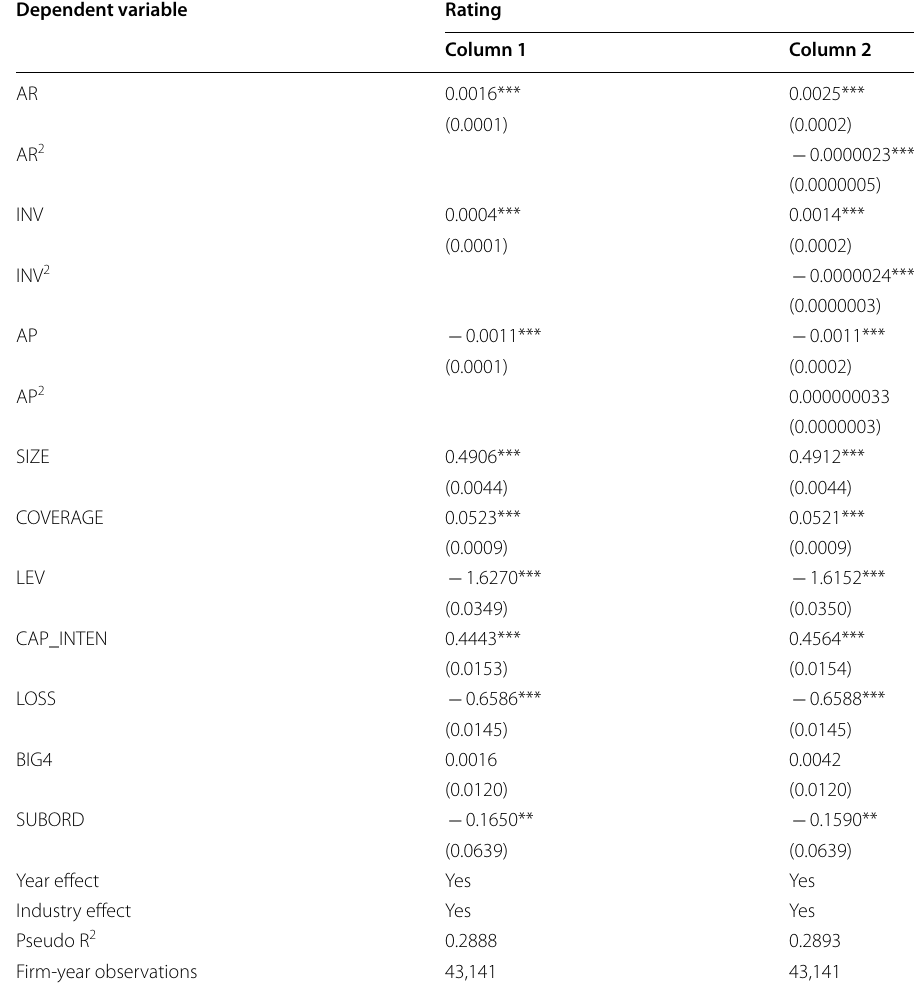
Table 7 Ordered Probit regression results of the relationship between working capital components (accounts receivable, inventory, and accounts payable) and credit